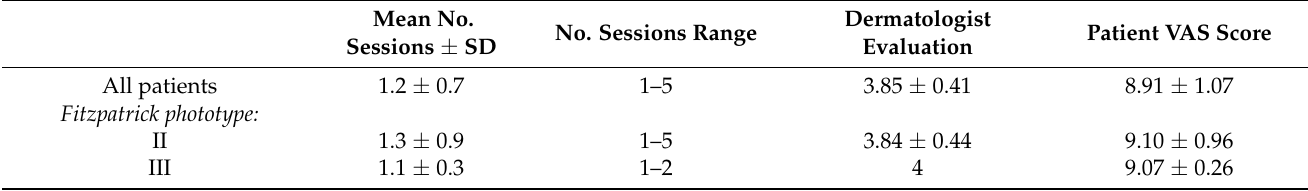
Table 2. Clinical parameters and removal scores in different